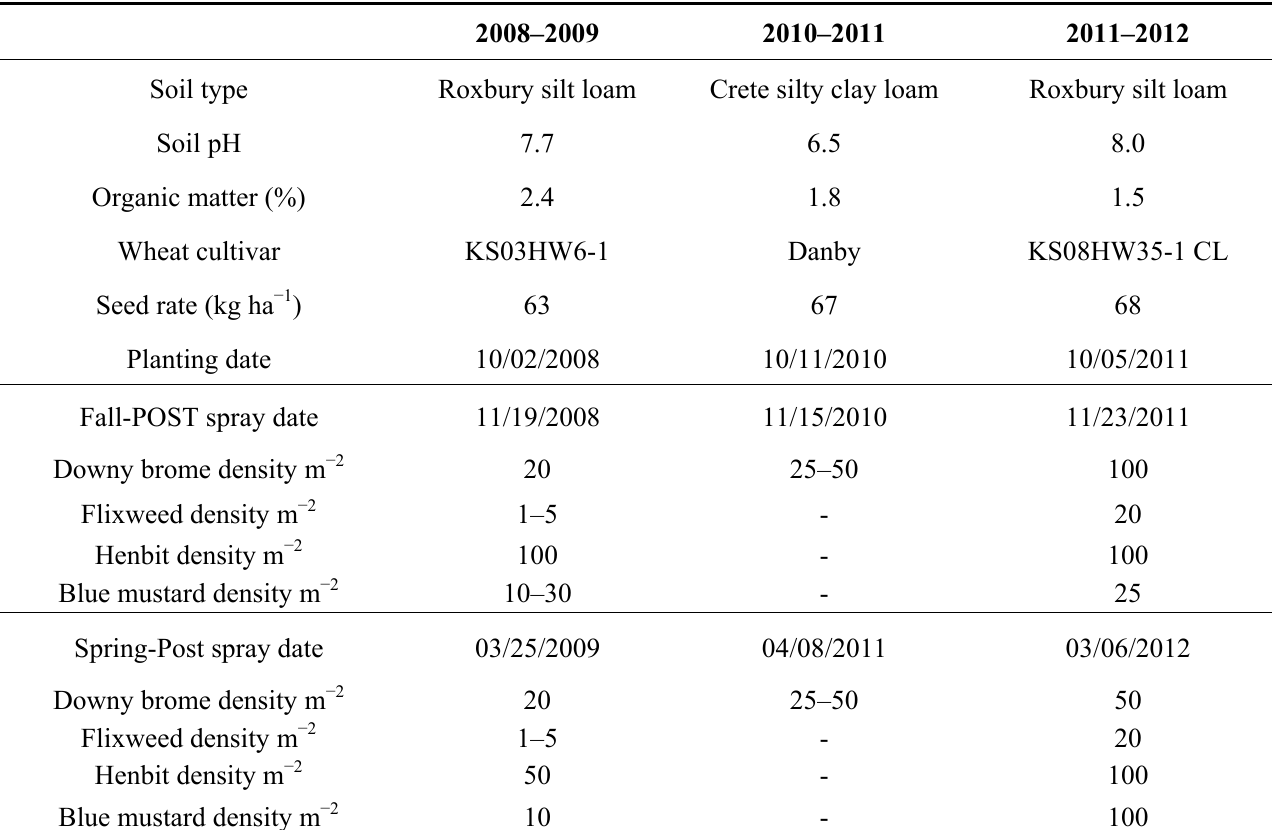
Table 1. Soil characteristics, planting, spraying and weed density information, Hays, KS, USA,